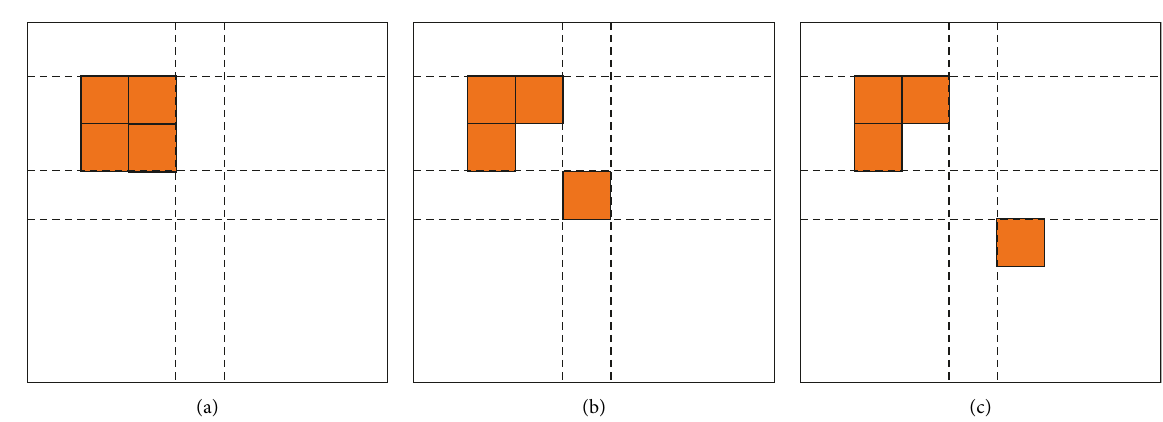
Figure 5: Several possible distributions of two-dimensional data. (a) True distribution. (b) One possible prediction distribution 1. (c) One possible prediction distribution 2.